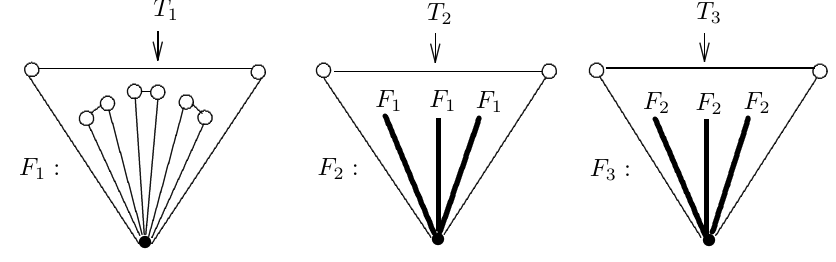
Figure 13: The plane graphs F